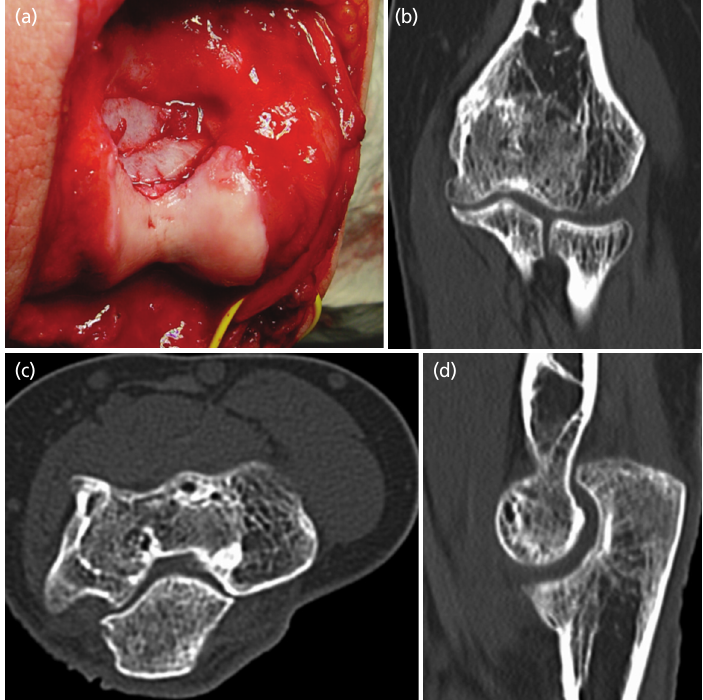
Fig. 2: Intra- and post-operative images of the same elbow: (a) posterior view after autologous bone grafting. (b) Coronal, (c) axial and (d) sagittal CT-images made three years after tumour removal. The trochlea is anatomically shaped and filled with